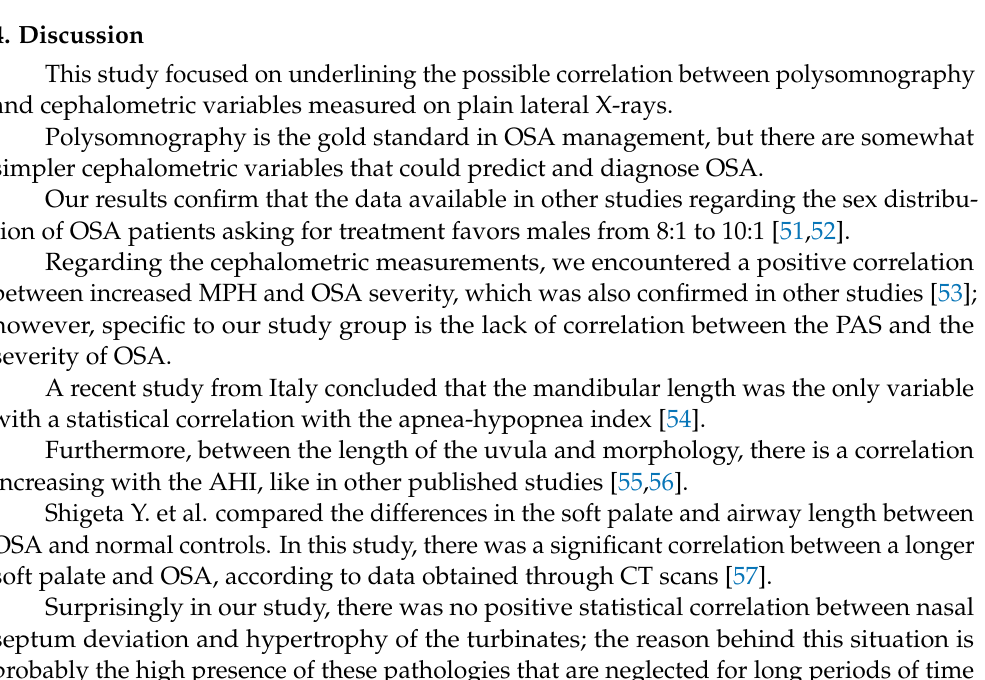
Figure 3. Graphic representation of the correlation between AHI and uvula